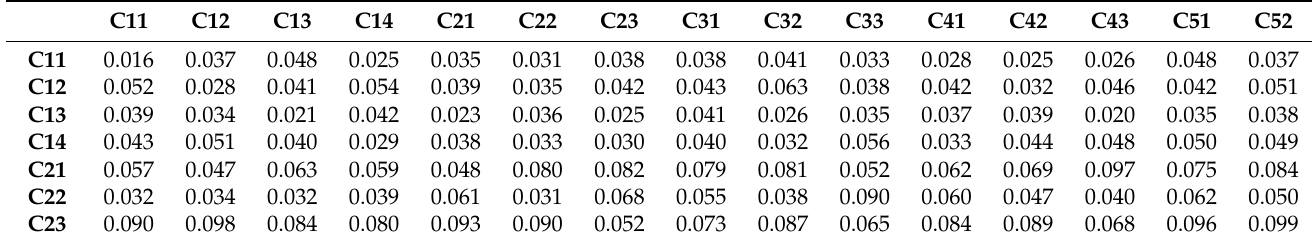
Table A11. Weighted matrix in the present